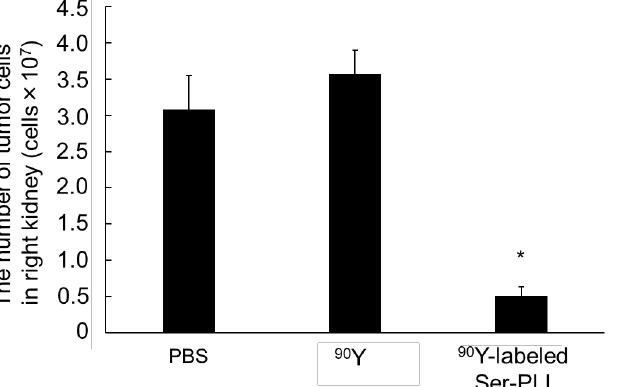
Figure 6. Effects of 90 Y-labeled Ser-poly-L-lysine (Ser-PLL) on kidney tumor growth after tumor induction and intravenous injections. Number of Colon26/Luc cells in kidneys of mice intravenously injected either with free 90 Y or with 90 Y-labeled Ser-poly-L-lysine (Ser-PLL). Mice were sacrificed 14 d after tumor inoculation. Data are means ± SE for seven mice. * statistically significant difference compared with PBS group ( p < 0.05).